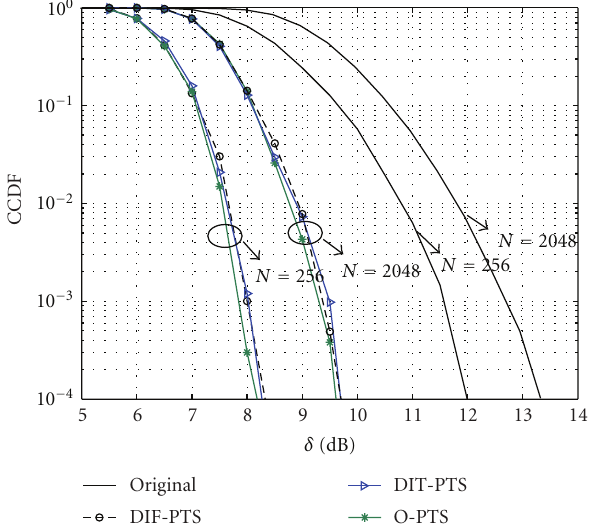
Figure 12: CCDF of DIF-PTS compared with DIT-PTS for r = 2 at stage m − v = 5 and O-PTS with N =